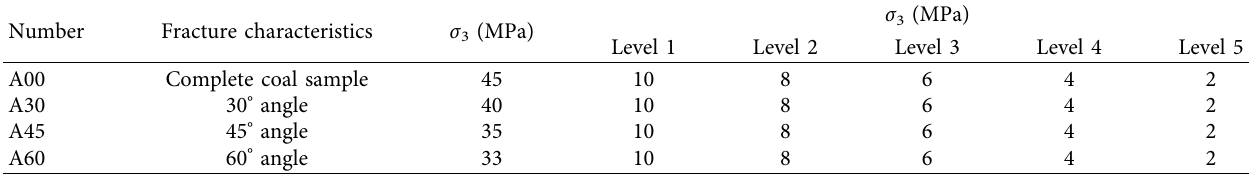
Table 1: Testing schemes of grading unloading pressure in the triaxial creep test.